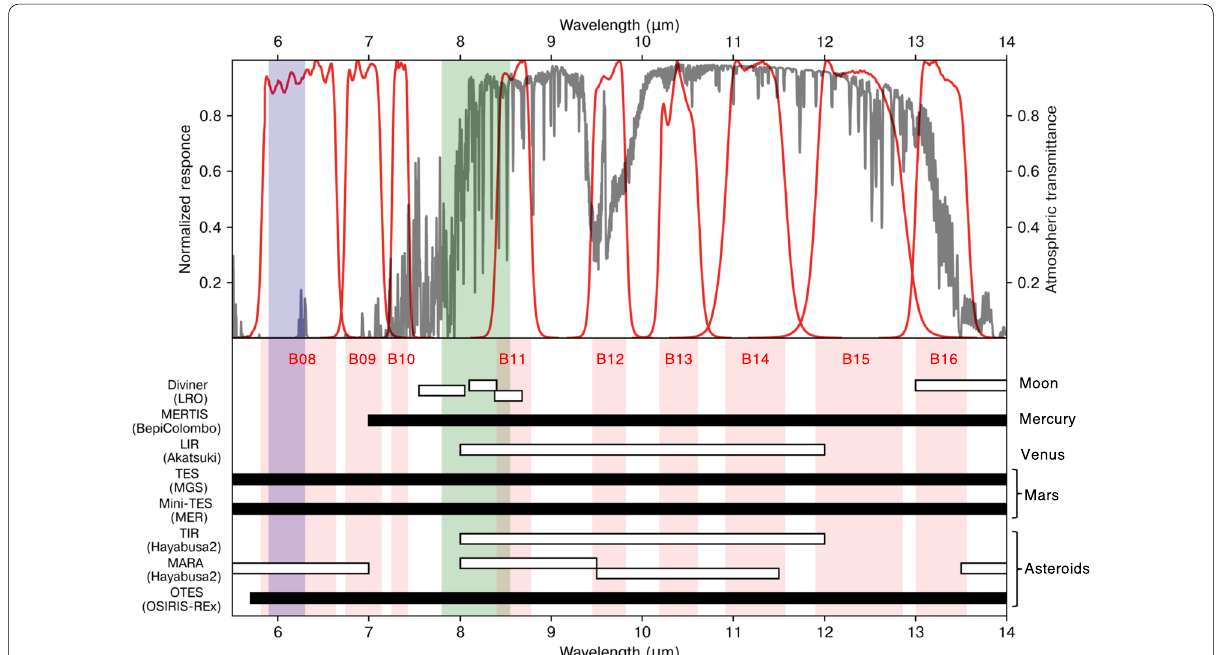
Fig. 1 (Upper) The AHI’s nine spectral passbands in mid-infrared wavelength. The red lines are the normalized response functions of bands 8–16 of AHI. The gray line is the atmospheric transmission calculated by ATRAN (Lord (1992); https:// atran. arc. nasa. gov/ cgi- bin/ atran/ atran. cgi). The blue and green shades correspond to wavelengths of water emission and Christiansen feature, respectively. (Lower) Comparison with other instruments onboard planetary exploration missions. The white and black bars are the response ranges of imagers and spectrometers on interplanetary spacecraft. The red shades and numbers are the AHI coverages and corresponding band